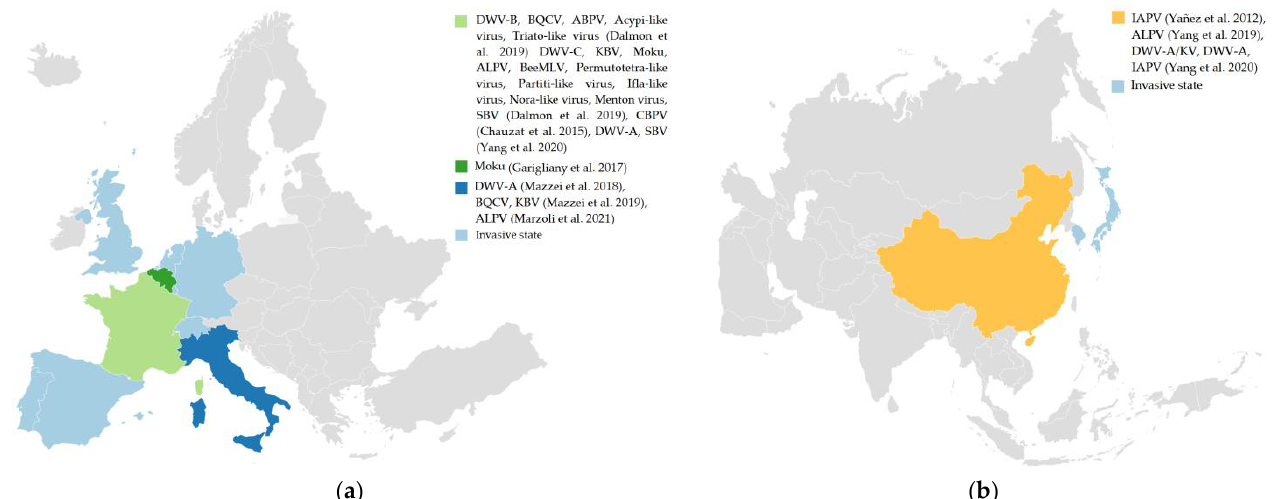
Figure 1. Studies on bee viruses of V. velutina in the invasive area in Europe; ( a ) and in its